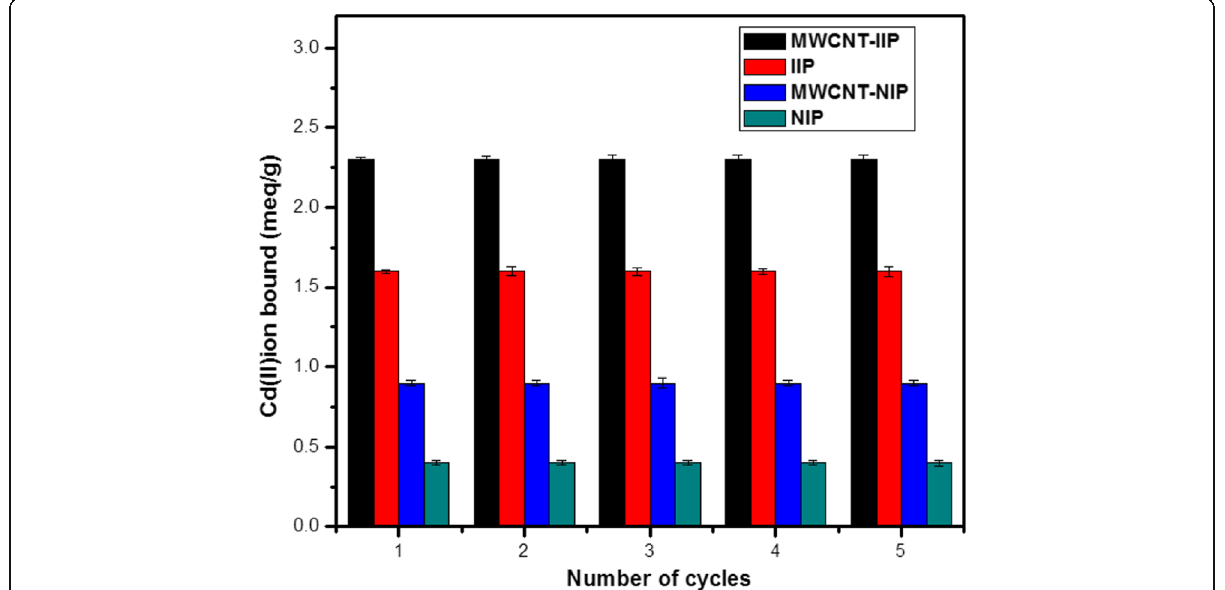
Fig. 20 Reusability studies of MWCNT-IIP, MWCNT-NIP, IIP, and NIP towards Cd(II) ion